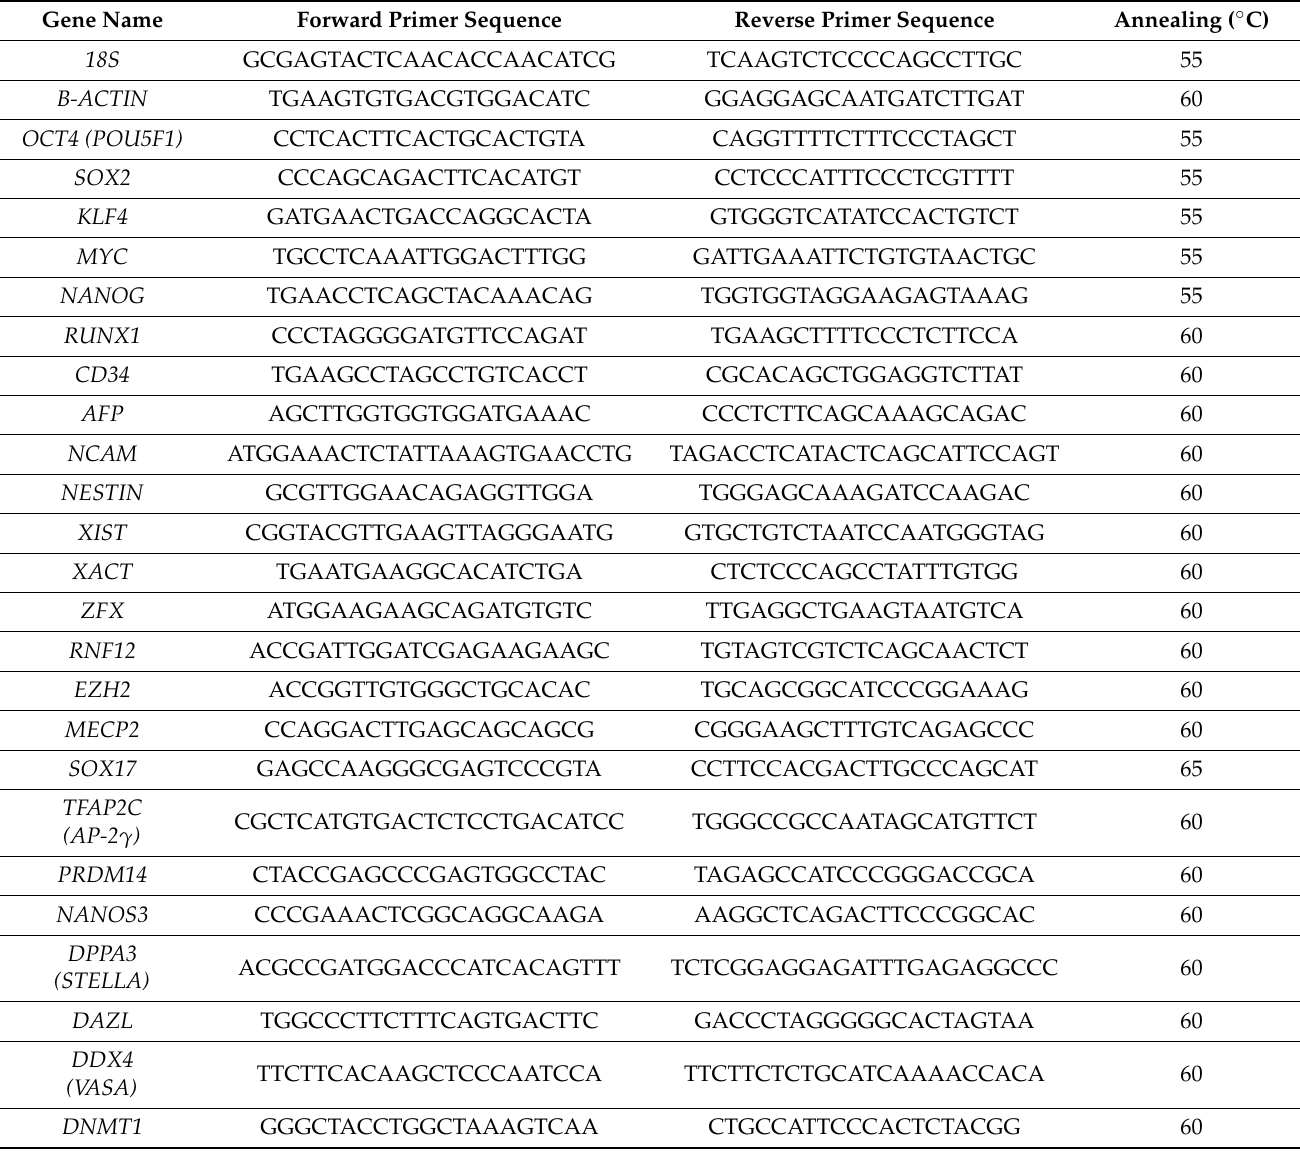
Table 2. Sequence of RT-qPCR primers related to experimental